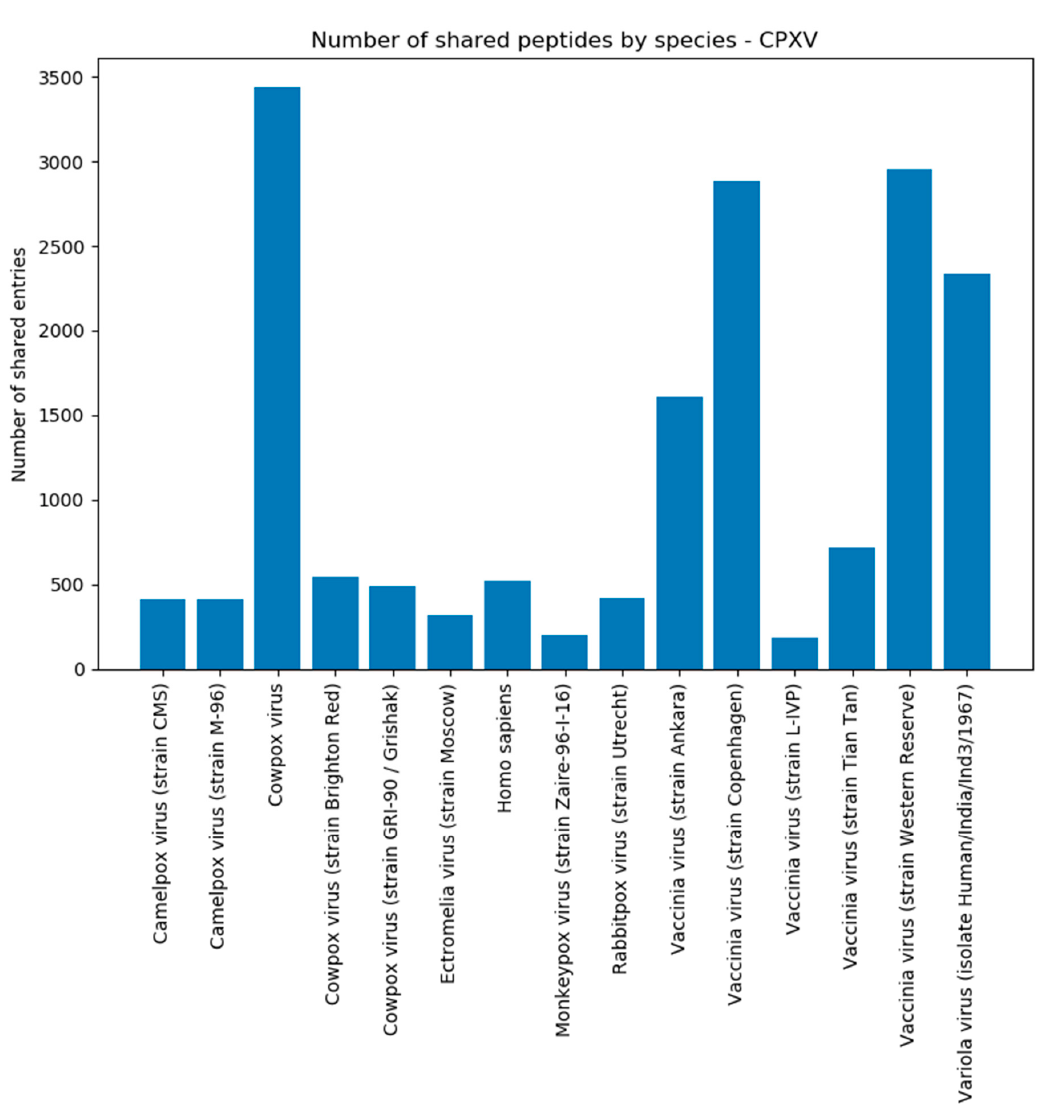
Figure 8. Number of shared CPXV peptides by species / strain assigned. This plot shows the number of shared peptides that Purple detected in the background for a species / species after the CPXV Brighton Red target analysis. All species that contribute less than 0.5% to the total amount of shared peptides were removed.